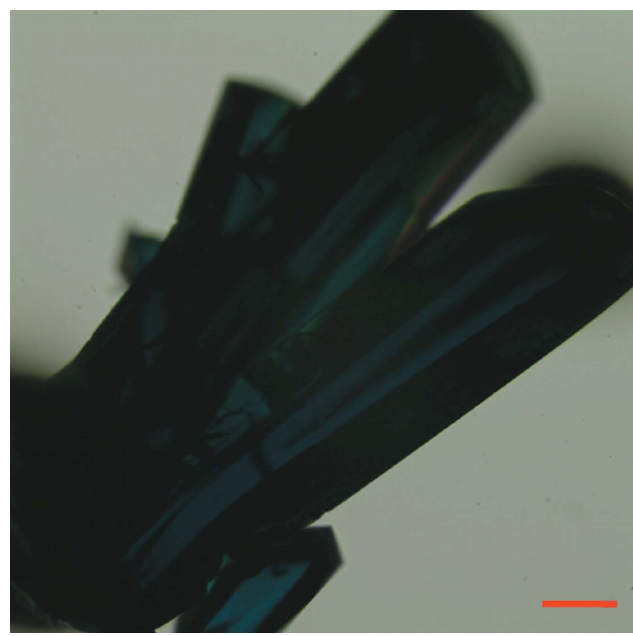
Figure 3 Crystals of the title complex. The length of the red scale bar represents 0.1 mm.